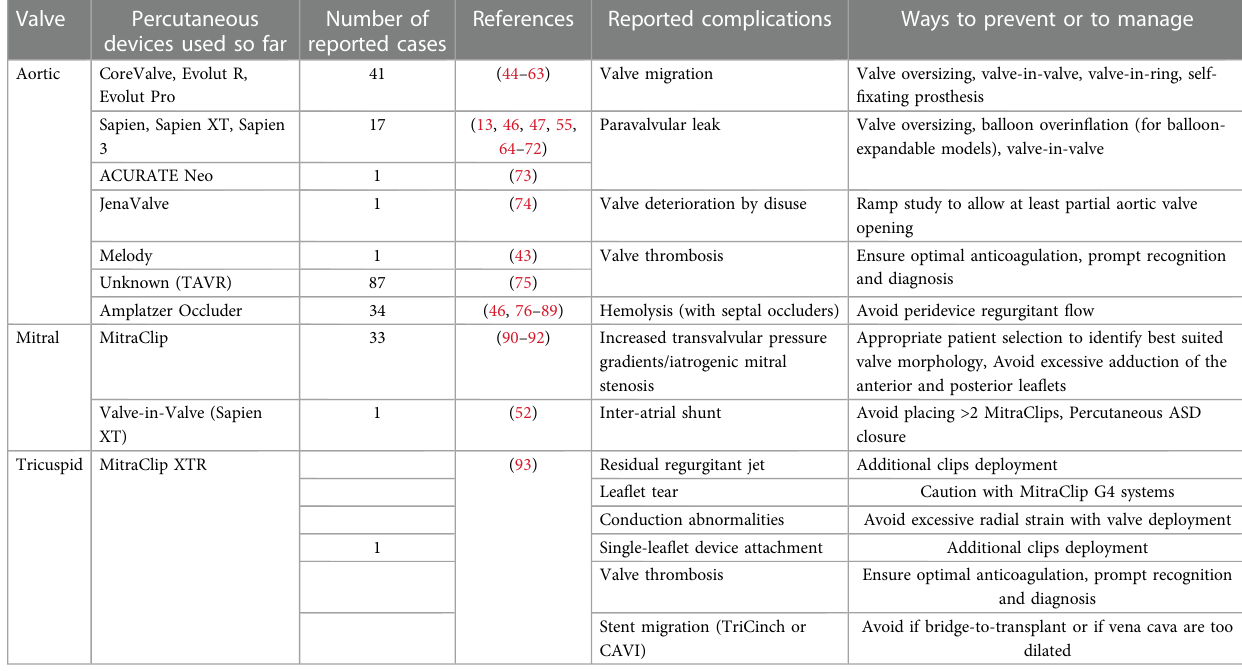
TABLE 1 Percutaneous devices used so far and potential complications of transcatheter heart valve interventions under left ventricular assist device support. Valve Percutaneous Number of devices used so far reported